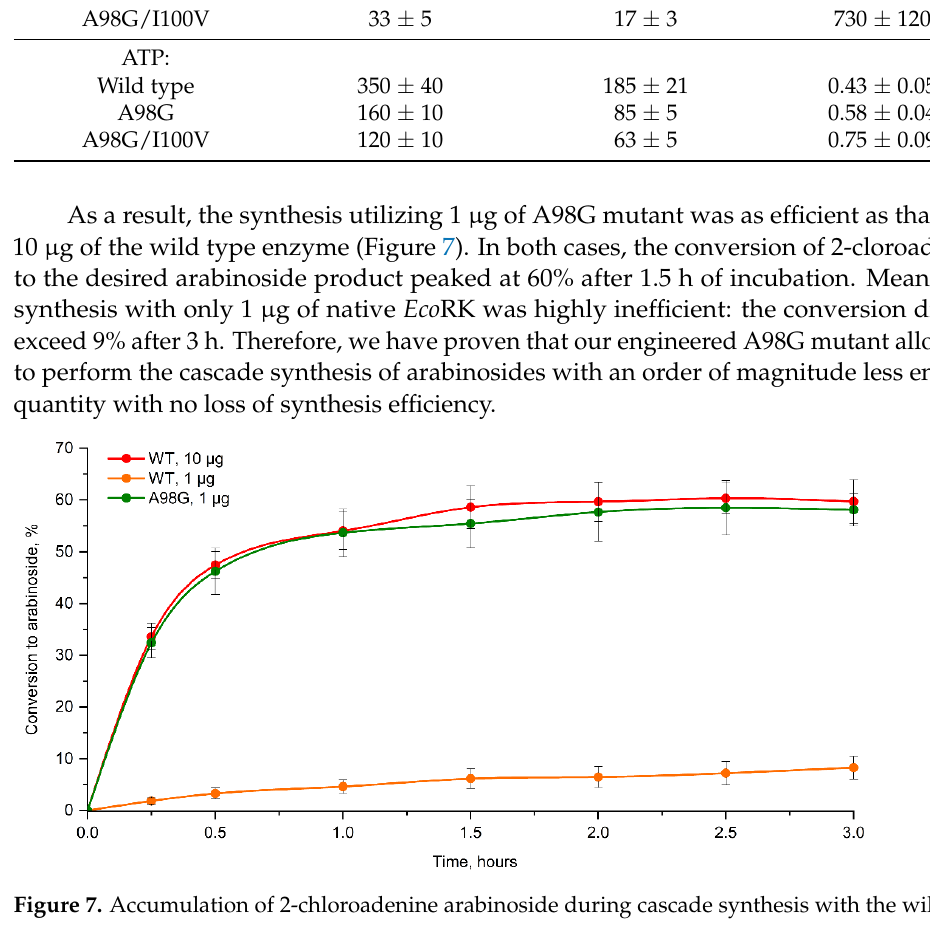
Figure 7. Accumulation of 2-chloroadenine arabinoside during cascade synthesis with the wild type Eco RK and the A98G mutant. The data are presented in mean values with standard deviation. Data represented in mean values and standard deviation (in three